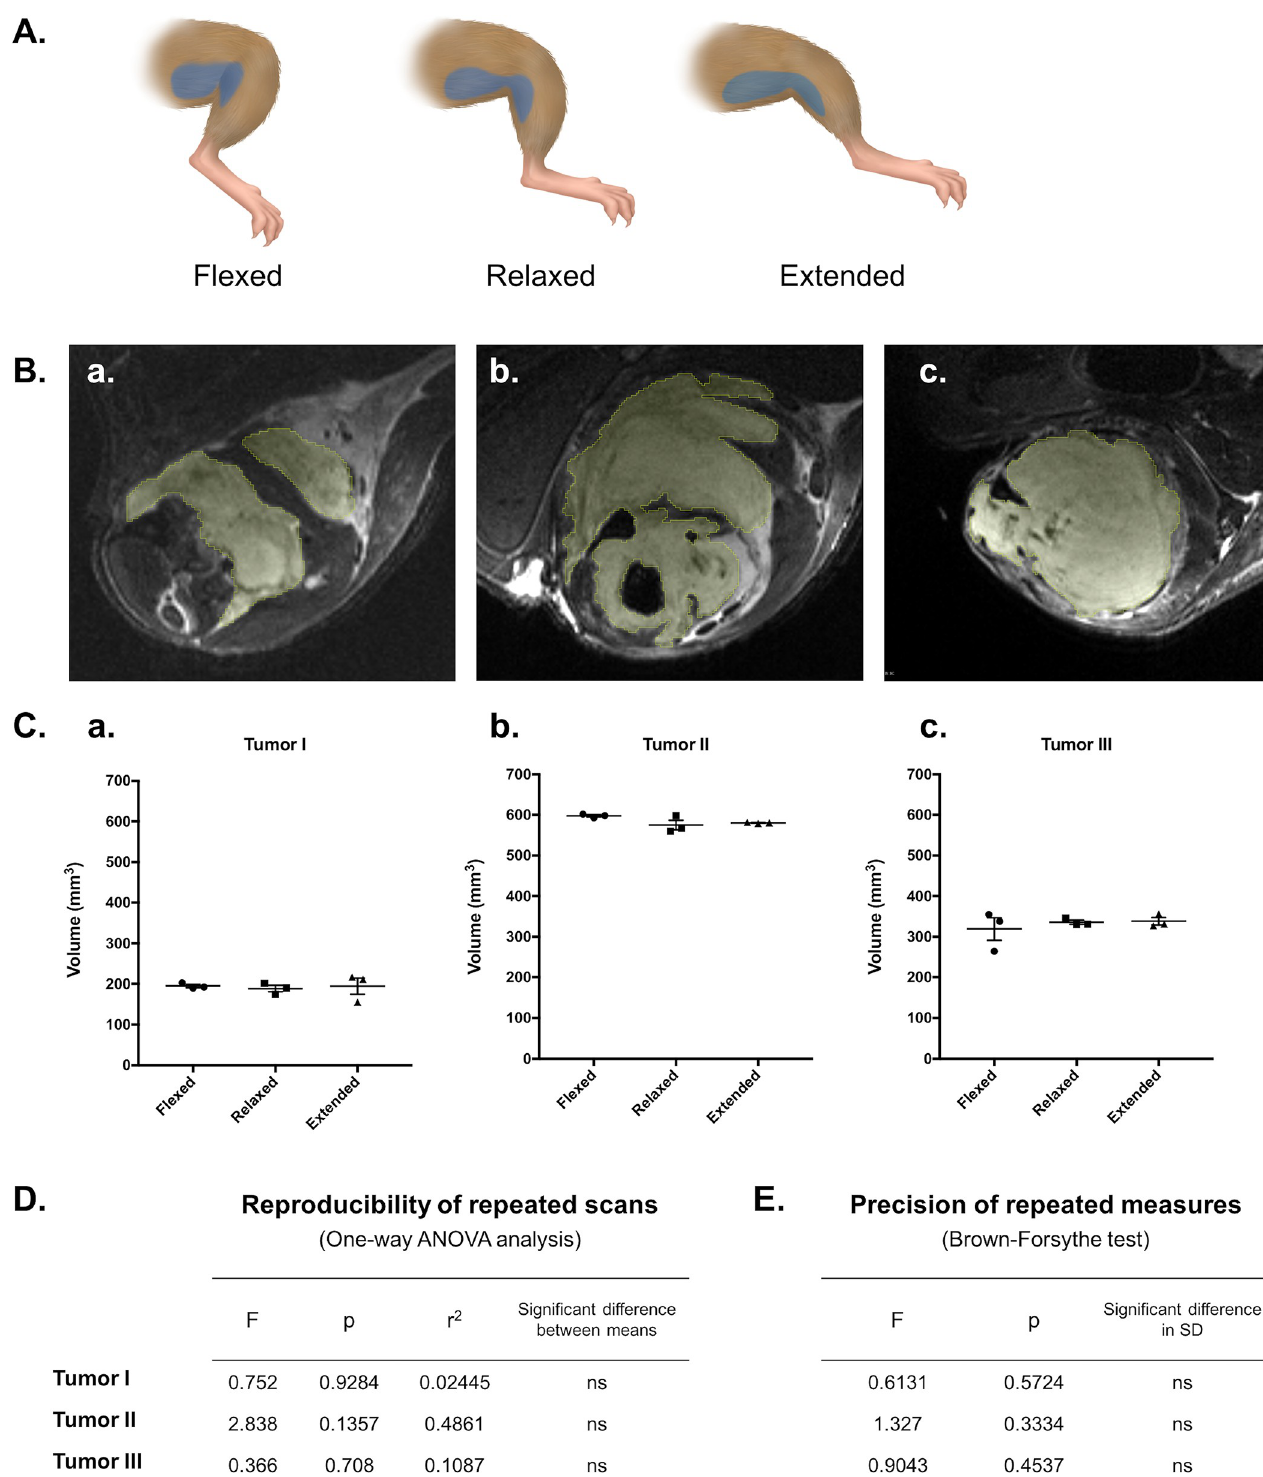
Fig 6. Reliability and consistency of tumor volume measurements in repeated scans with limb repositioning. T2-weighted images were analyzed to determine reproducibility of tumor volume measurements resulting from three consecutive scans of sarcoma-bearing limbs in three positions. Each mouse was scanned three times in succession, with the tumor-bearing limb positioned under the surface coil in a flexed, relaxed, or extended position to shift the location and shape of the tumor (represented as blue in the diagram shown in (A)). ROIs were hand-drawn slice-by-slice in triplicate in each resulting image (9 total